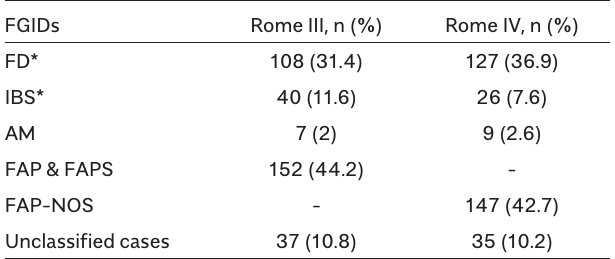
Figure 1. The frequency of the diagnoses of functional dyspepsia (FD), irritable bowel syndrome (IBS), abdominal migraine (AM), functional abdominal pain (FAP), functional abdominal pain syndrome (FAPS), and functional abdominal pain, not otherwise specified (FAP-NOS) according to Rome III and Rome IV